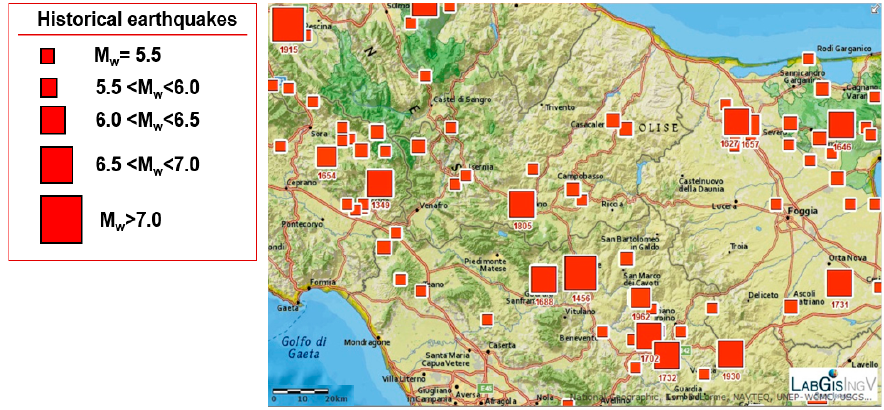
Figure 2. Distribution of earthquake intensities occurring on Thursday, October 31st 2002 [22].